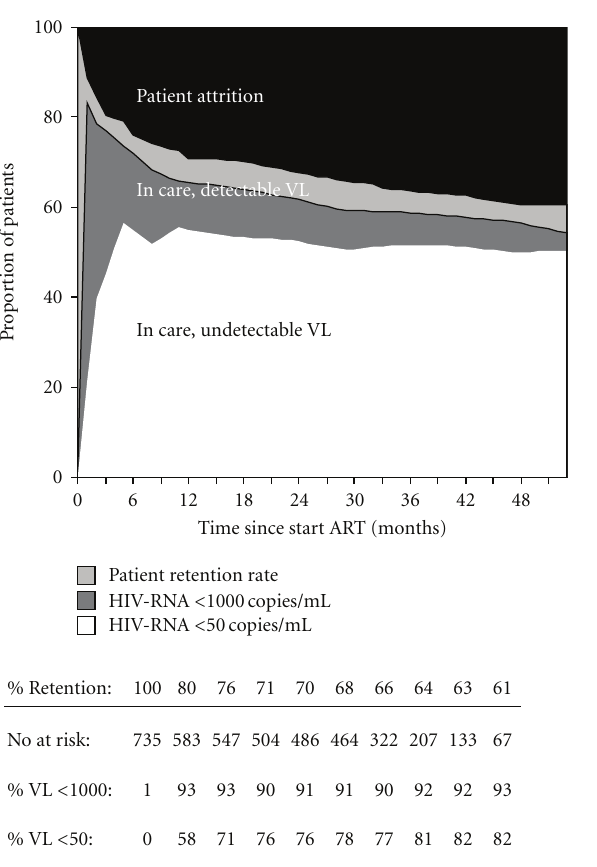
Figure 1: Virological treatment outcome.